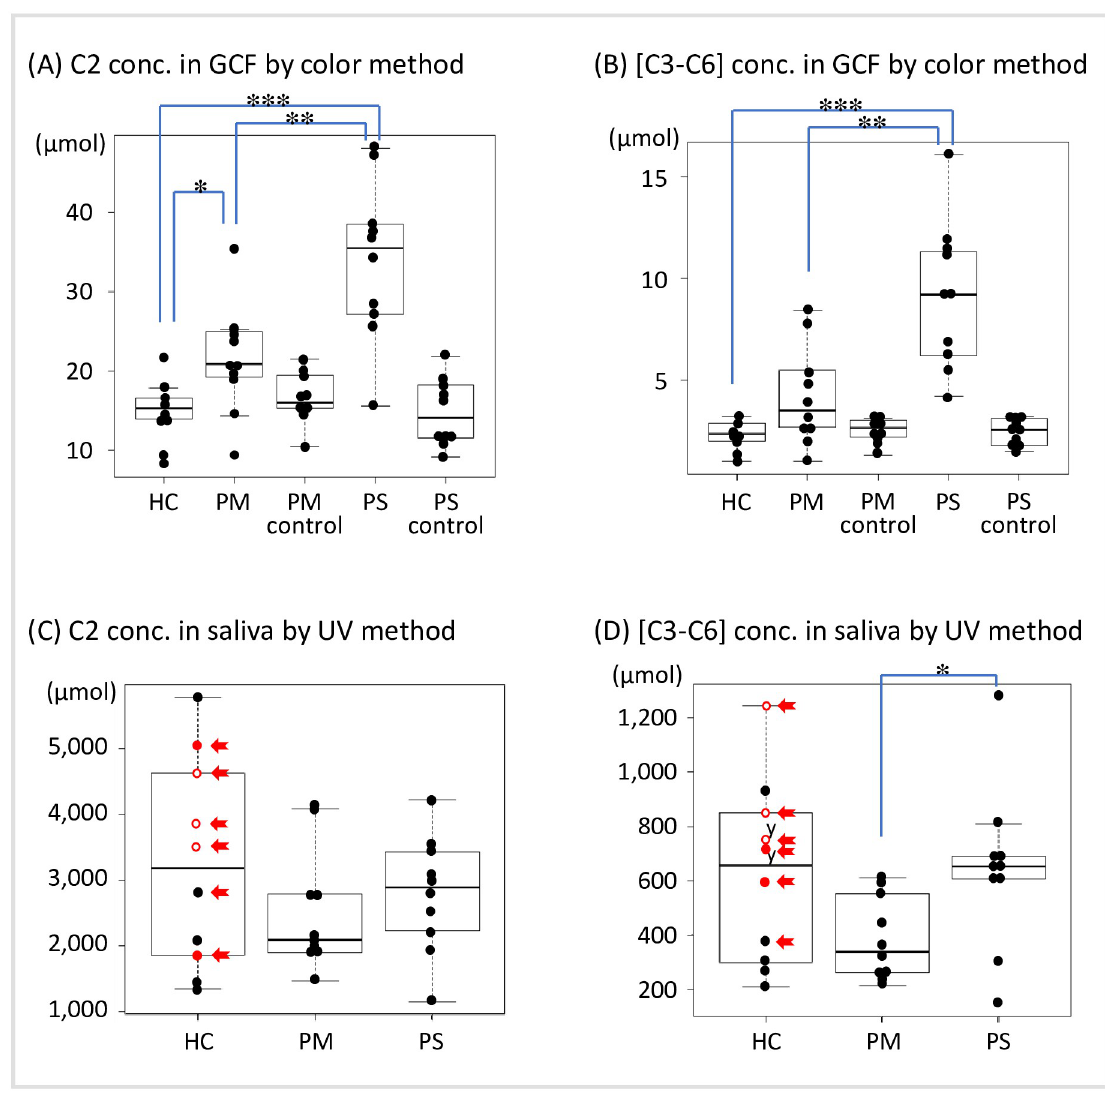
Fig 3. Concentration distribution of C2 and [C3–C6] in periodontal disease severity. (A) C2 and (B) [C3–C6] in the GCF were measured using the color method. (C) C2 and (D) [C3–C6] in the saliva were measured using the ultraviolet rays method as in Fig 2. C2 and [C3–C6] concentrations in the saliva and GCF are shown in a boxplot with the interquartile range. Mann–Whitney U test; � : p < 0.05, �� : p < 0.01, ��� p < 0.001. The samples of PM control and PS control shown in (A) and (B) are GCF samples collected from healthy teeth (PD � 3 mm) from the PM and PS groups. The red closed dots indicate a PISA > 100 mm 2 , and the open dots indicate a PISA > 300 mm 2 after 1.5 years. The red arrow indicates the sample in which Porphyromonas gingivalis was present in the GCF. C2, acetic acid; [C3–C6], propionic acid, butyric acid, isobutyric acid, valeric acid, isovaleric acid, and caproic acid; GCF, gingival crevicular fluid; PM, mild group; PS, severe group; PD, probing depth; PISA, periodontal inflamed surface area.